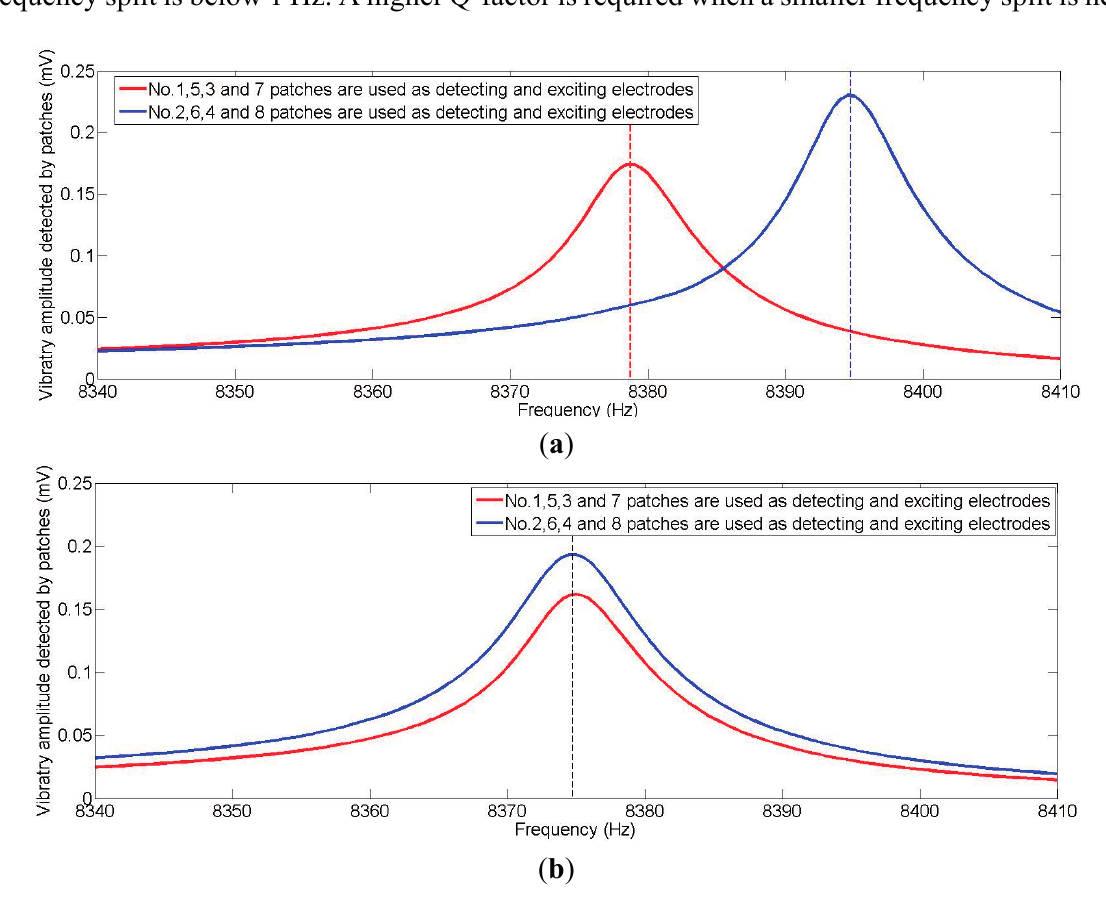
Figure 17. ( a ) Frequency spectrogram of the resonator before eliminating the frequency split; ( b ) Frequency spectrogram of the resonator after eliminating the frequency